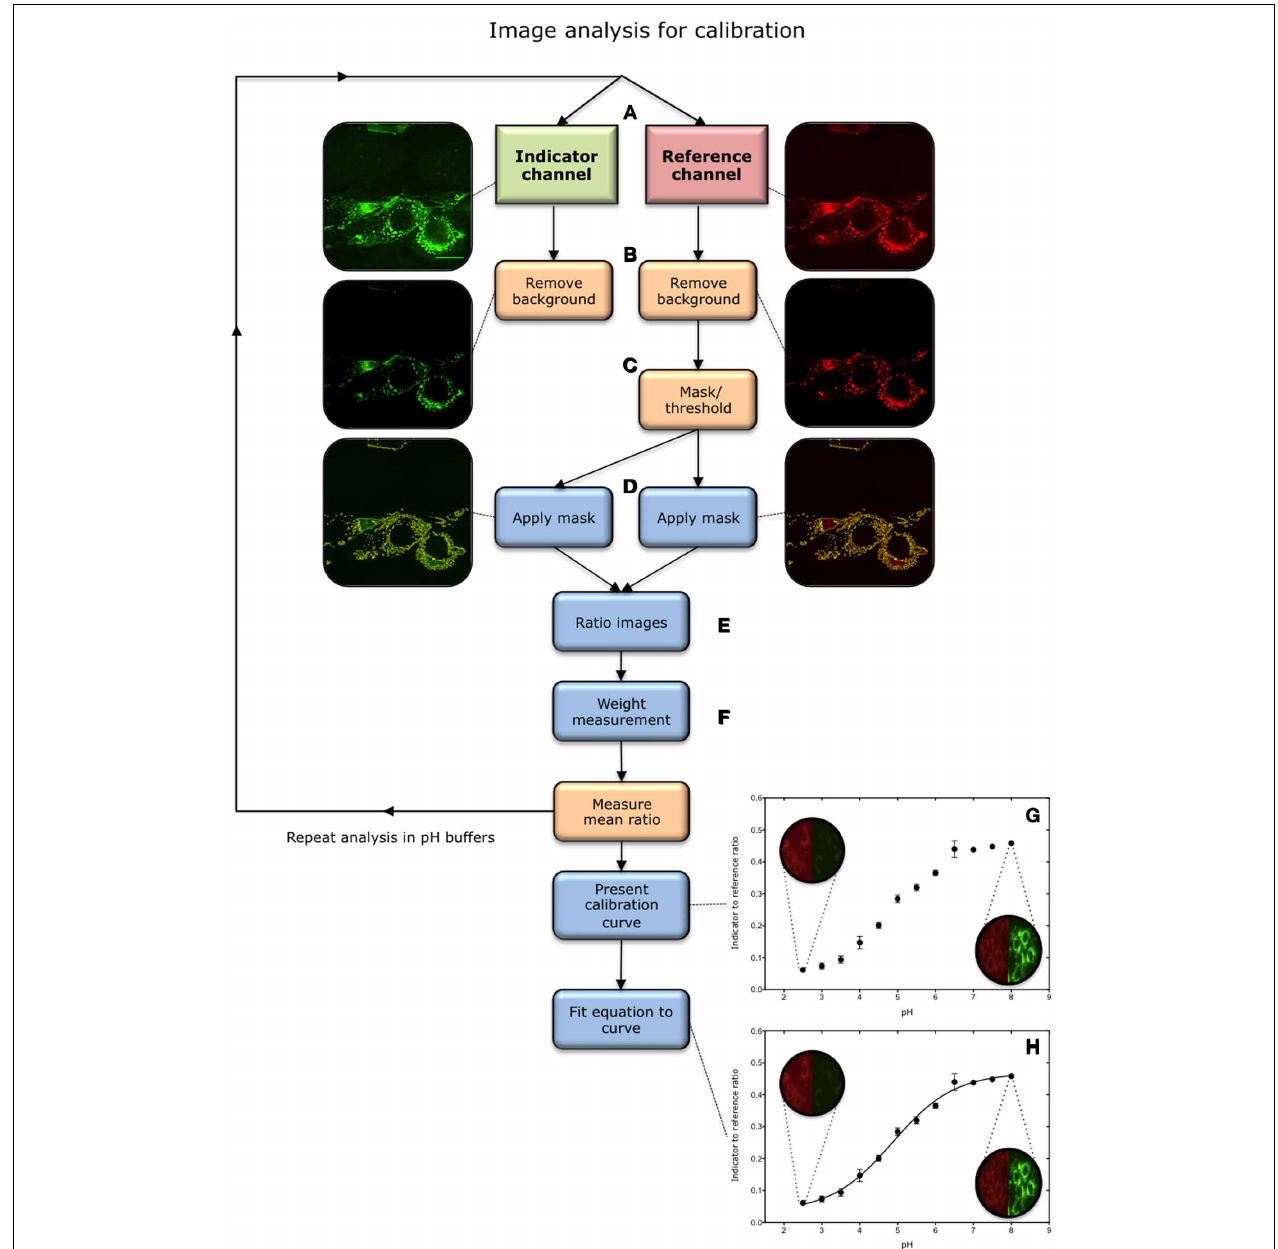
FIGURE 3 | Overview ofimage analysis processforcalibration. (A) Images areacquired intheindicator(green) andreference (red) channels inauniversal buffersolutionofknownpH.Thecentralmostin-focussliceselectedforanalysis. (B) Background isremoved inboth channels. (C) Pixelscontainingnanosensor signalareisolatedfromtheimage.Thisisachievedbyapplyingathresholdtothe reference image, above whichpixelsareconsidered tocontainnanosensors.